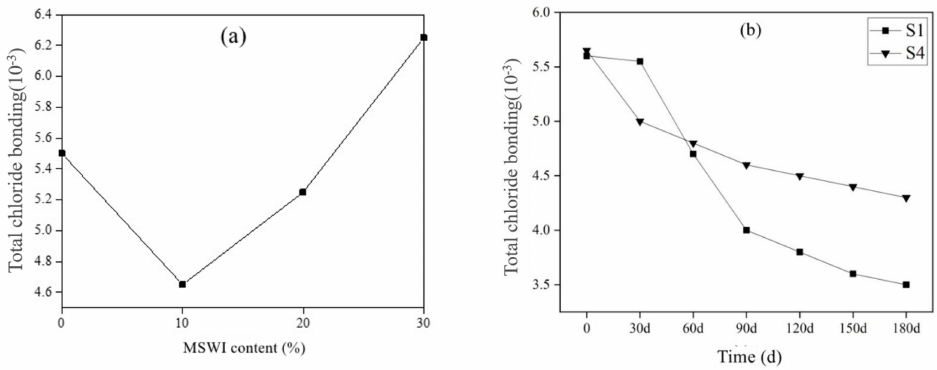
Figure 13. Total chloride ion bonding of MSWI recycled cement-based material at different dosage ( a ) and age ( b ).